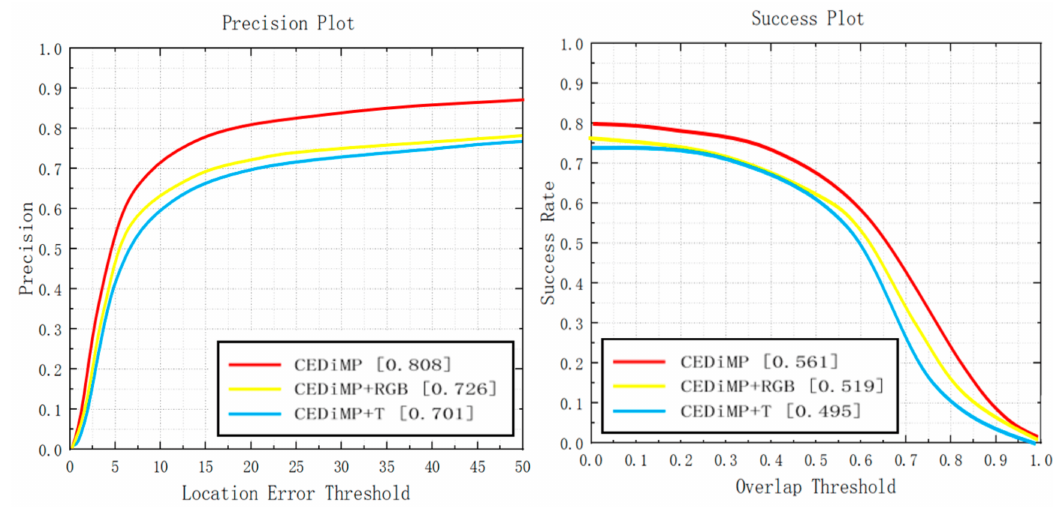
Figure 13. Single/dual-modal experiments